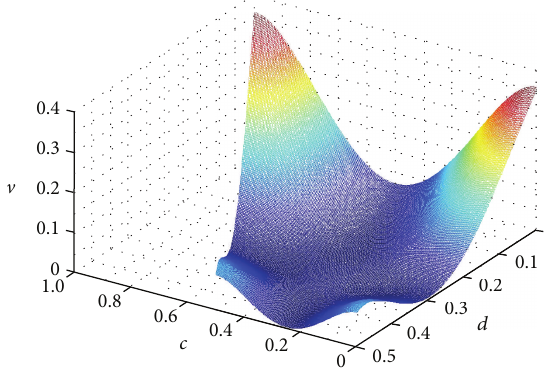
Figure 16: Relationship of V with 𝑑 and 𝑐 .